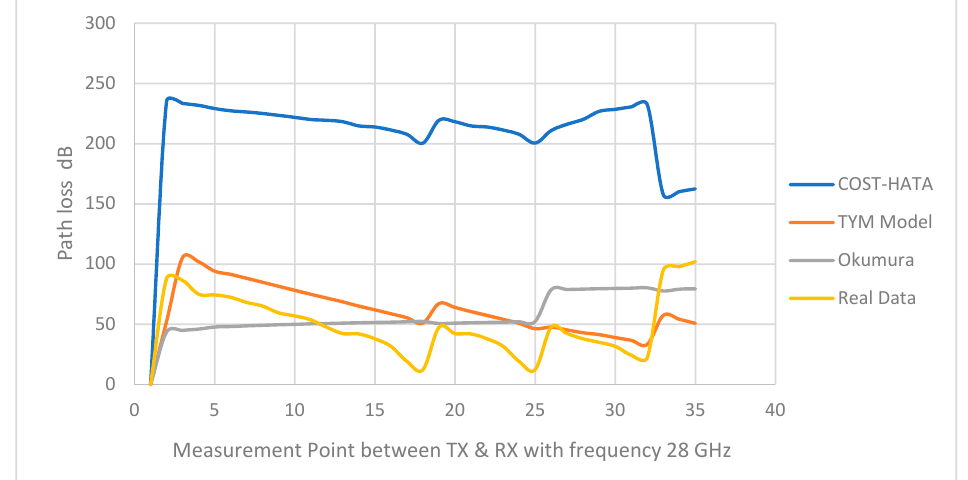
Figure 11. Comparison between the TYM model and the other models with a frequency of 28 GHz.